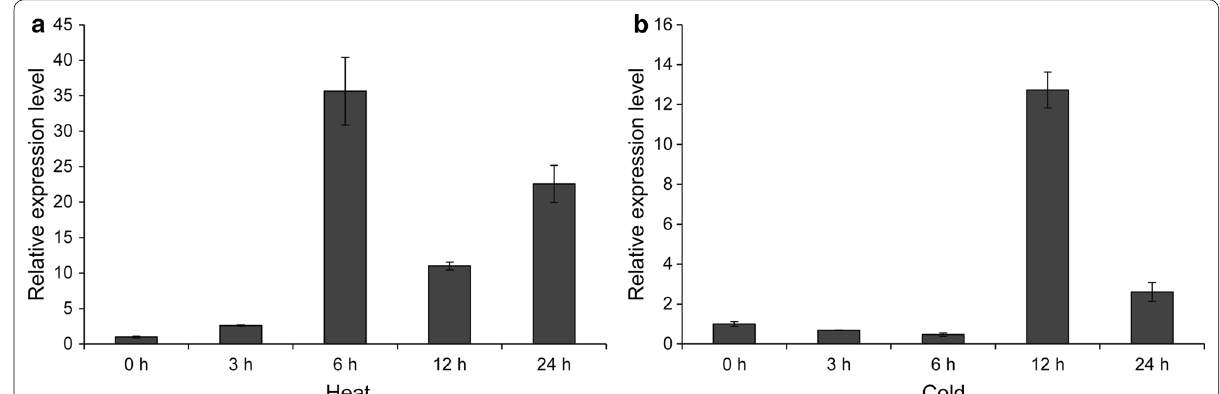
Fig. 4 qRT-PCR analysis of CsLEA11 expression in the leaves of cucumber plants under heat ( a ) and cold ( b ) stress conditions. The results are the mean SD of three independent experiments ±